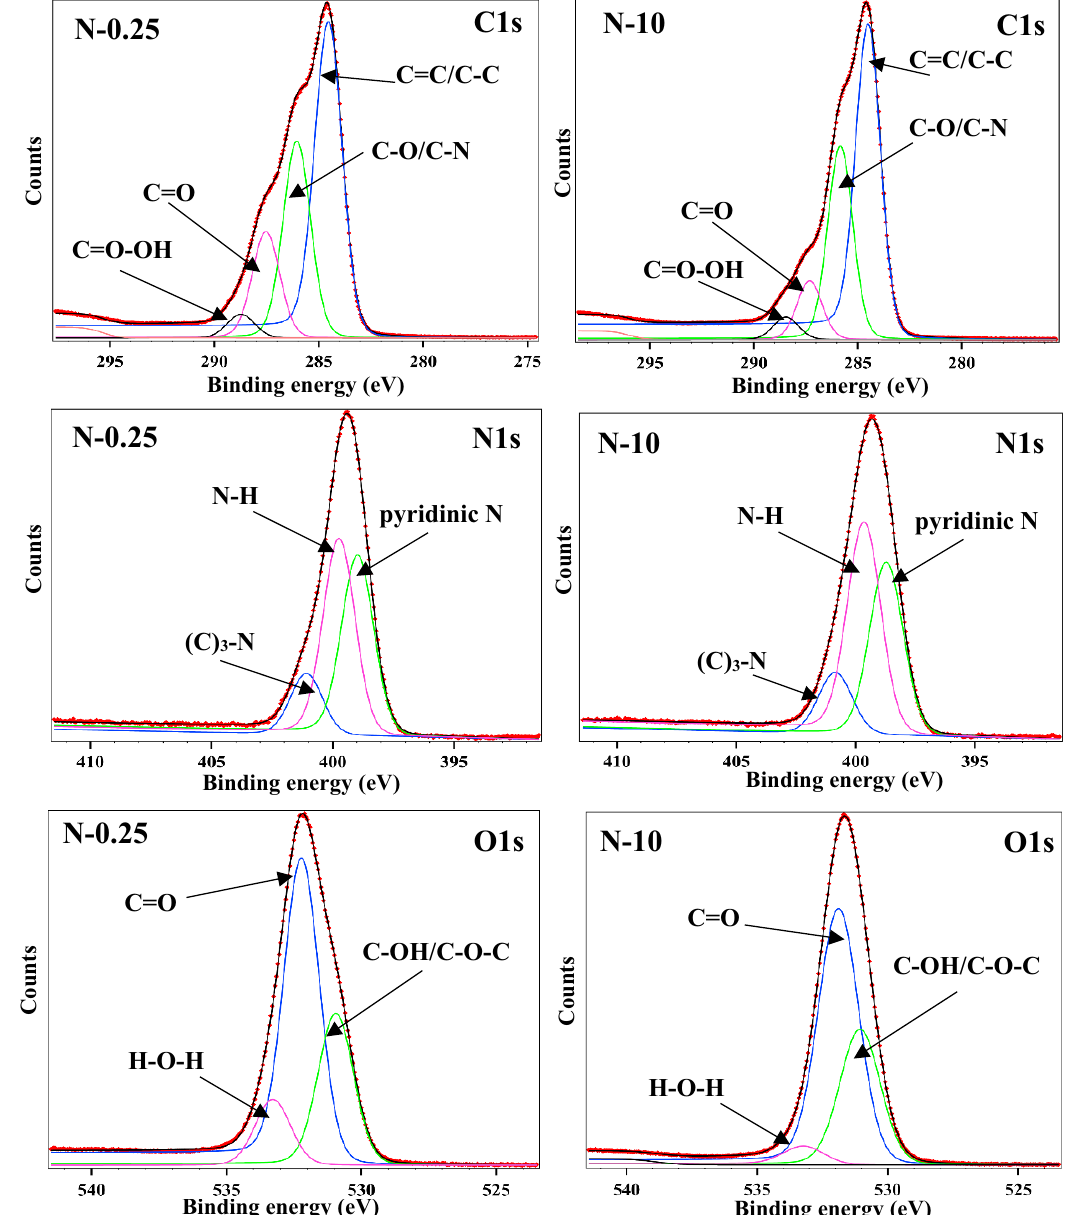
Figure 3. Representative XPS spectra of N-CQDs showing the lowest (N-0.25) and highest (N-10) nitrogen doped samples. The spectra display three typical peaks C1s (285.0 eV), N1s (399.0 eV), and O1s (531.0 eV). The deconvoluted N1s band showed three peaks representing pyridinic N, N–H and amide